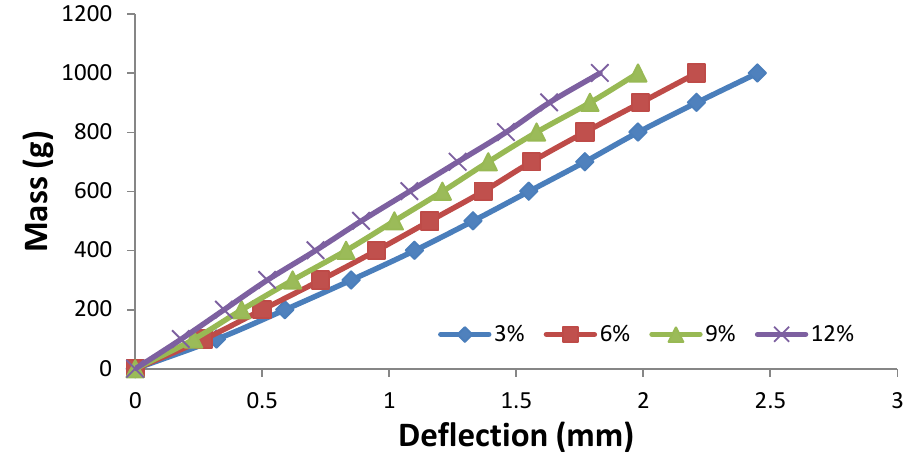
Fig. 2: Mass vairation with different concentrations of MgO in normal conditions.